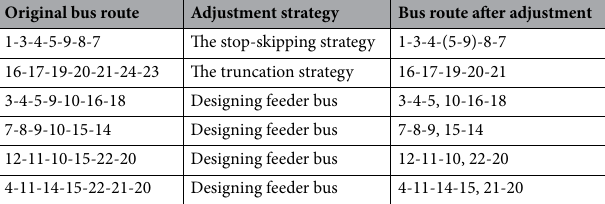
Original bus route Adjustment strategy